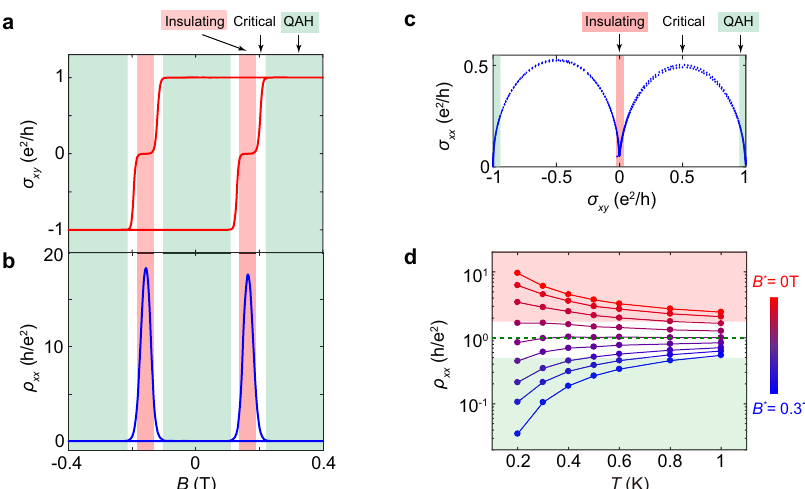
Fig. 1 QAH, quantum critical, and insulating regimes of QAH. a , b Magnetic fi eld dependence of σ xy and ρ xx measured at 50 mK. Upon fi eld sweeping, the QAH system can be tuned into the QAH, quantum critical, or insulating regime. c Plot of σ xx as a function of σ xy . A semicircle relationship is shown during the transition. d Temperature dependence of ρ xx under different B * , where B (cid:3) ¼ B (cid:2) μ metal-insulator transition at B (cid:3) ¼ B (cid:3) c (dashed green line) with a critical resistance of ~ h / e 2 .